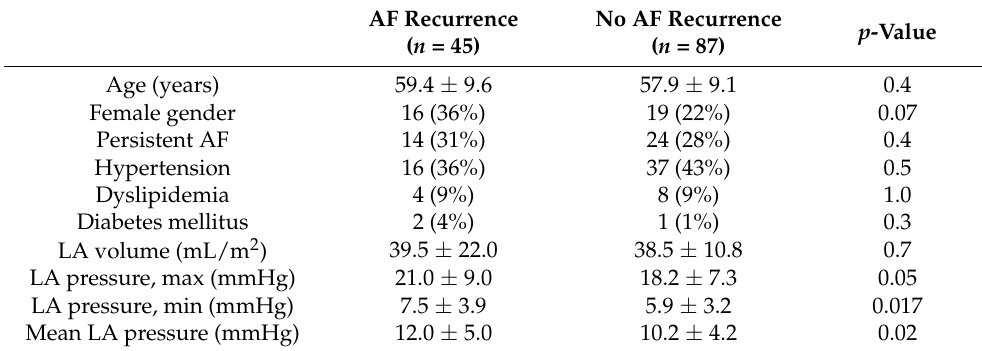
Table 3. Comparison of clinical characteristics between patients presenting AF